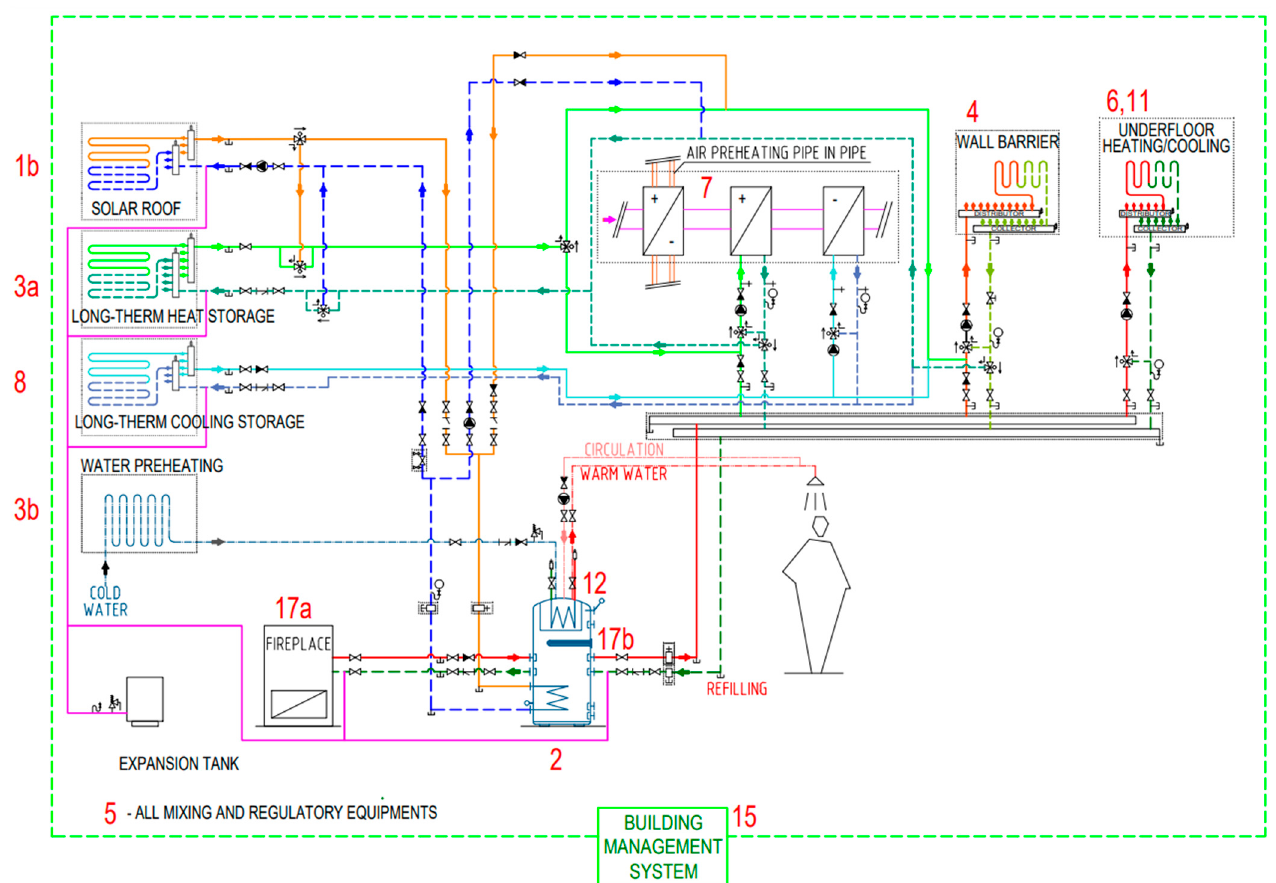
Figure 9. Simplified wiring diagram of the innovative technical solution for energy systems [21].